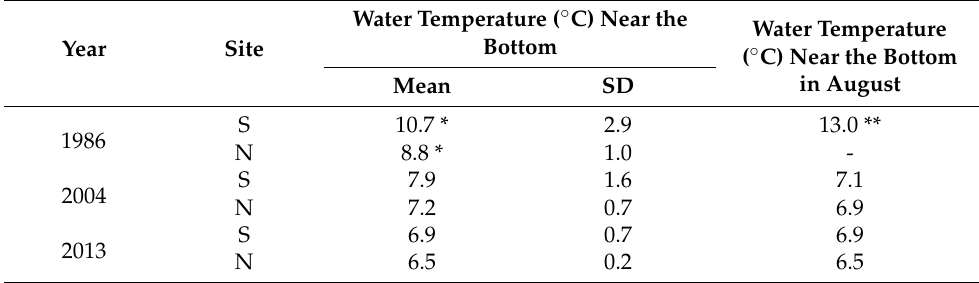
Table 3. Changes in water temperature in the years analyzed (May-October and during the stagnation peak). The data for 1986 were from Dunalska et al.* [20] and Lossow et al. ** [40]; S–the site in the southern basin of the lake, where the pipeline is located; N–the site in the northern basin of the lake. Water Temperature ( ◦ C) Near the Water Temperature Bottom Year Site ( ◦ C) Near the Bottom in AugustMean SD